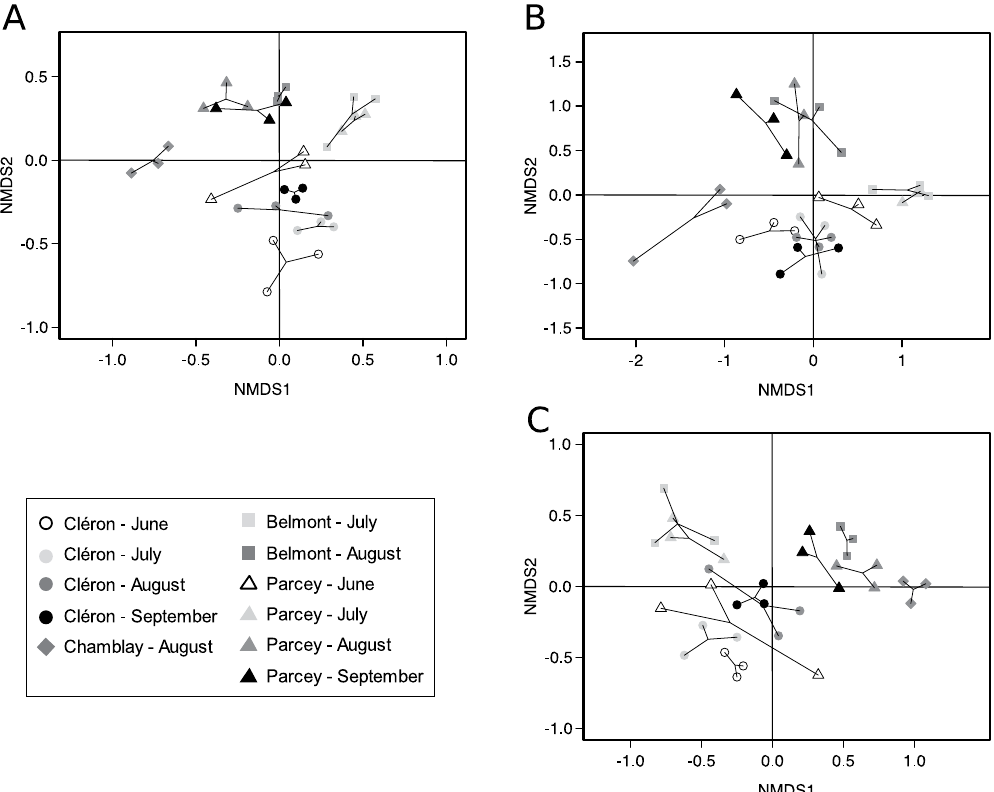
Figure 5. Nonmetric multidimensional scaling (NMDS) representing the diversity of the bacterial ( A ) and microeukaryotic communities ( B , C ) among the different sampling sites and dates. NMDS was performed using the 16S rRNA pyrosequencing dataset without chloroplast sequences ( A ), the 16S rRNA chloroplast pyrosequencing dataset ( B ), and the 18S rRNA pyrosequencing dataset ( C